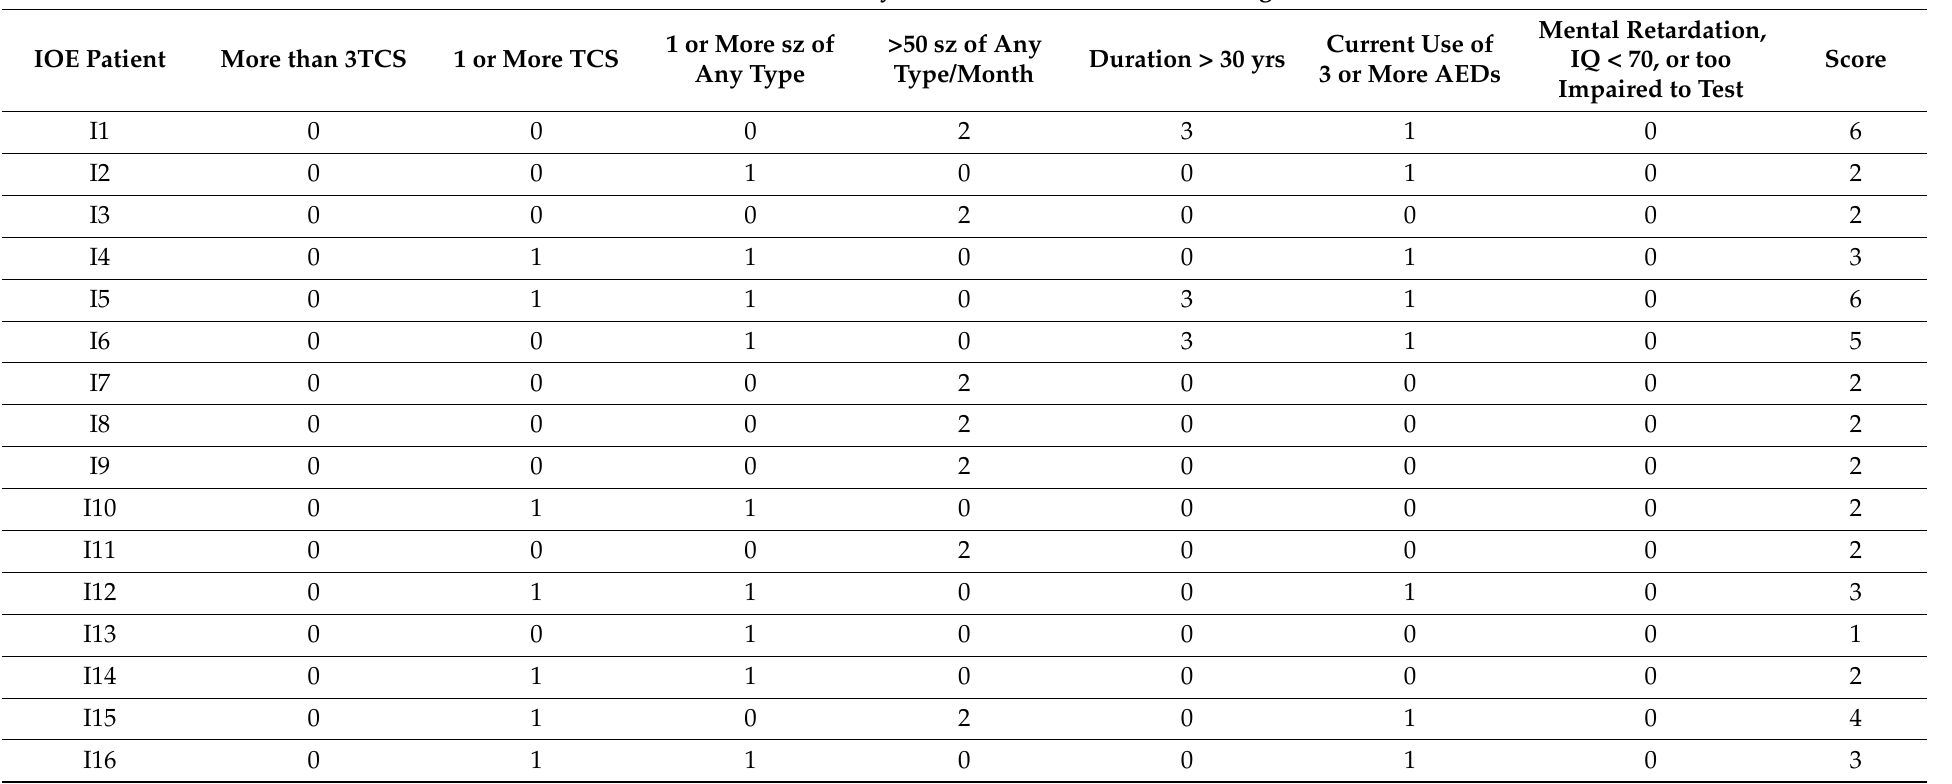
Table A1. The revised SUDEP-7 inventory scores of IOE and TLE